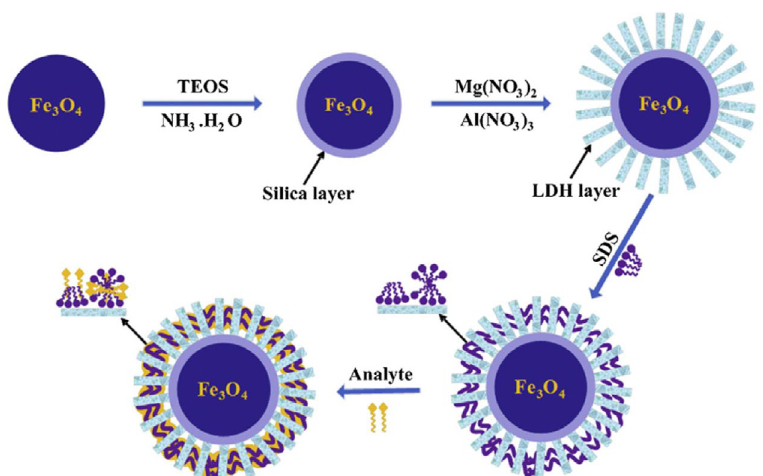
Fig. 2. Schematic illustration of the preparation of surfactants modified Fe O @SiO2@Mg–Al MLDH and its application for enrich 3 4 analytes as SPE sorbents Fig. 2 . Schematic illustration of the preparation of surfactants modified Fe 3 O 4 @SiO 2 @Mg–Al MLDH and its application for enrich analytes as SPE sorbents [28].